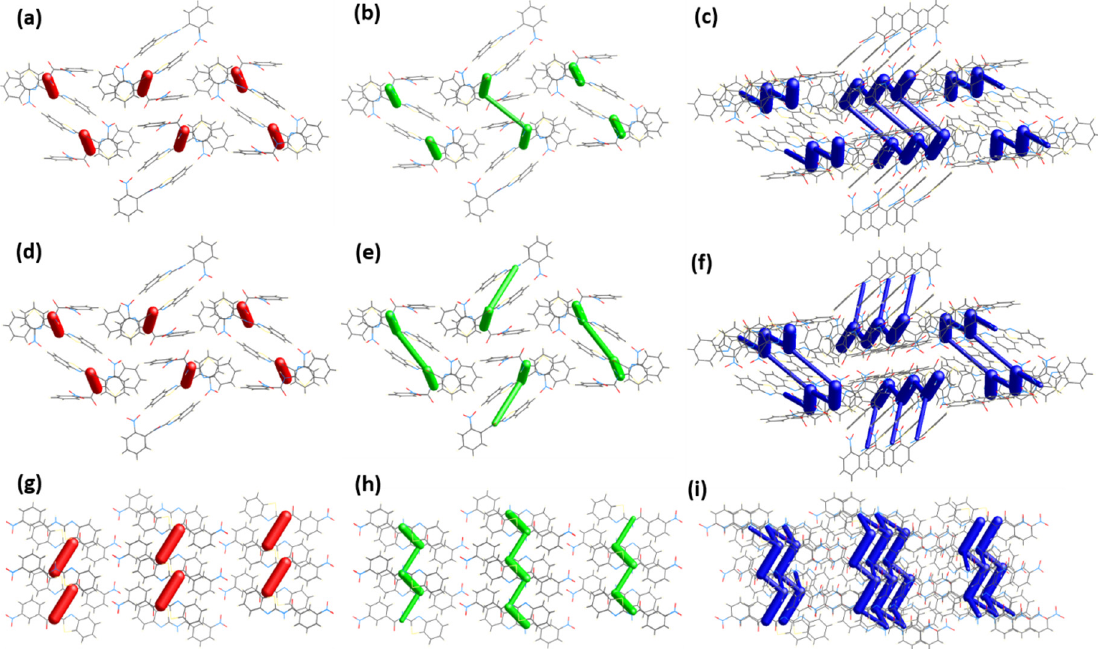
Figure 9. A comparison of energy framework (2 × 1 × 1 unit cell) comprised of ( a ) electrostatic ( b ) dispersion and ( c ) total energies for IA, ( d–f ) for IB, viewed from a -axis, and ( g – i ) corresponding diagrams for II (1 × 2 × 1 unit cell) viewed from b -axis. (Tube size scale factor = 80; energy threshold = 30 kJ · mol − 1 ) .